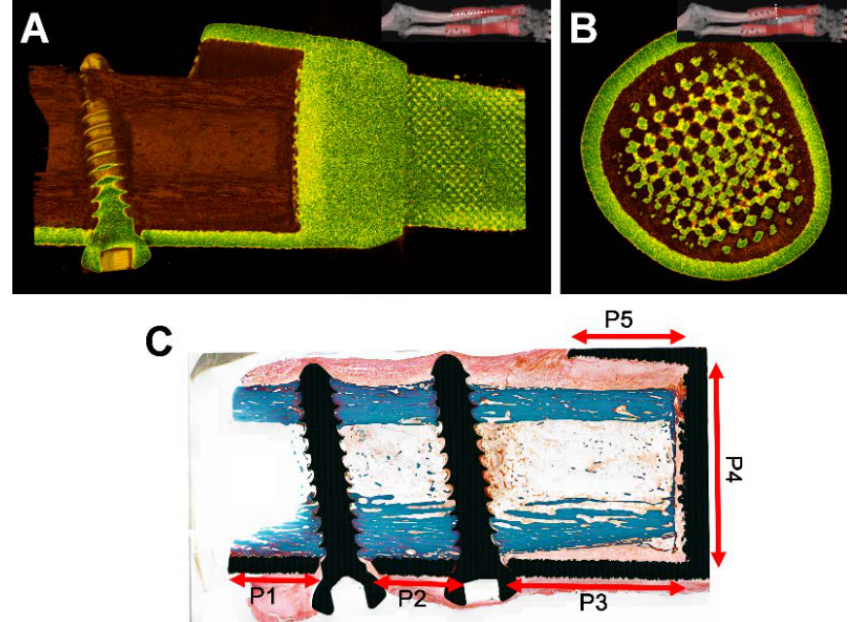
Figure 4. Analyzed segments of the proximal region. Micro-computed tomographic images showing ( A ) the longitudinal view and ( B ) axial view, with scout images in the upper right corner. Photomicrograph (( C ): Goldner’s trichrome staining, 1× magnification) of the histological specimen of the longitudinal section showing the analyzed segments (P1–P5).